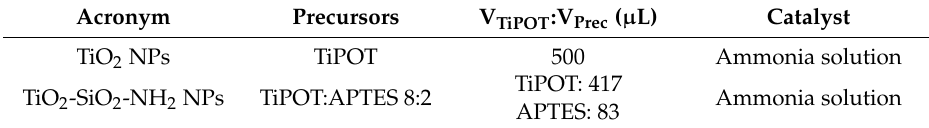
Table 3. Amorphous TiO 2 -based NPs: acronyms, compositions, and sol-gel precursor’s